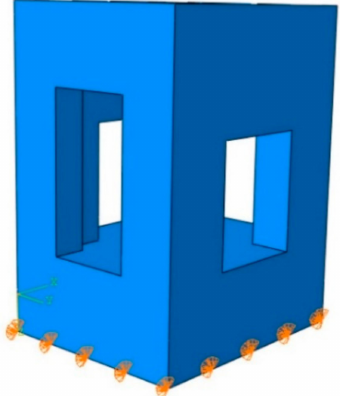
Figure 9. Boundary condition of the COF